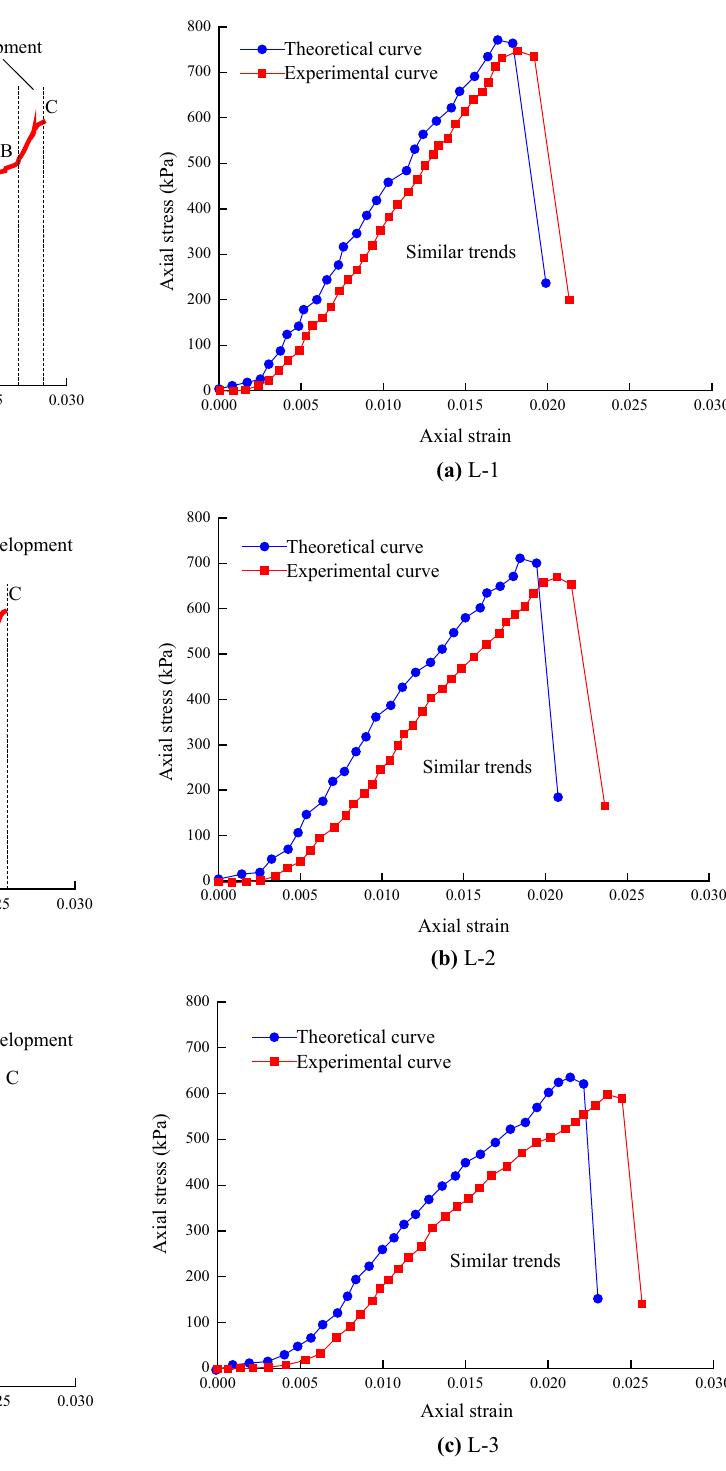
Fig. 14 Comparison of theoretical and experimental stress–strain